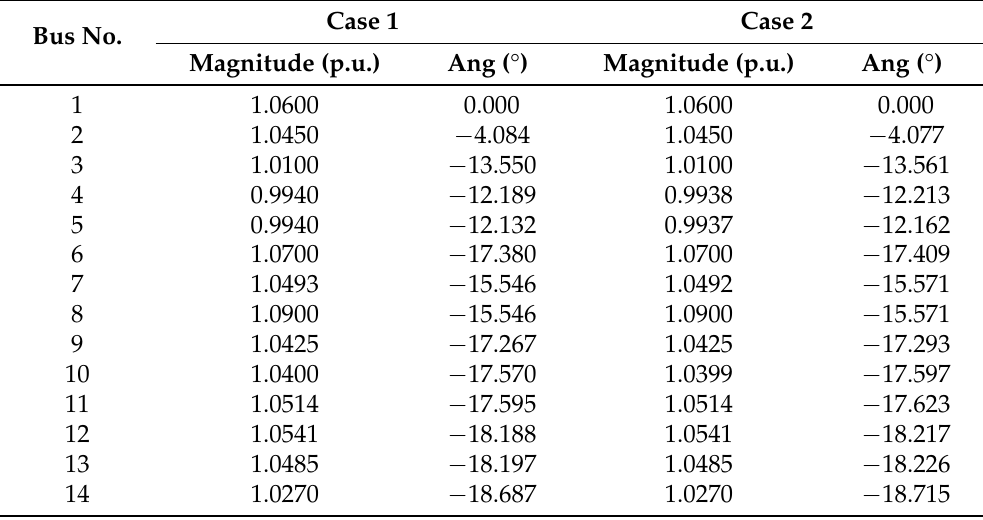
Table 11. AC bus voltage result.